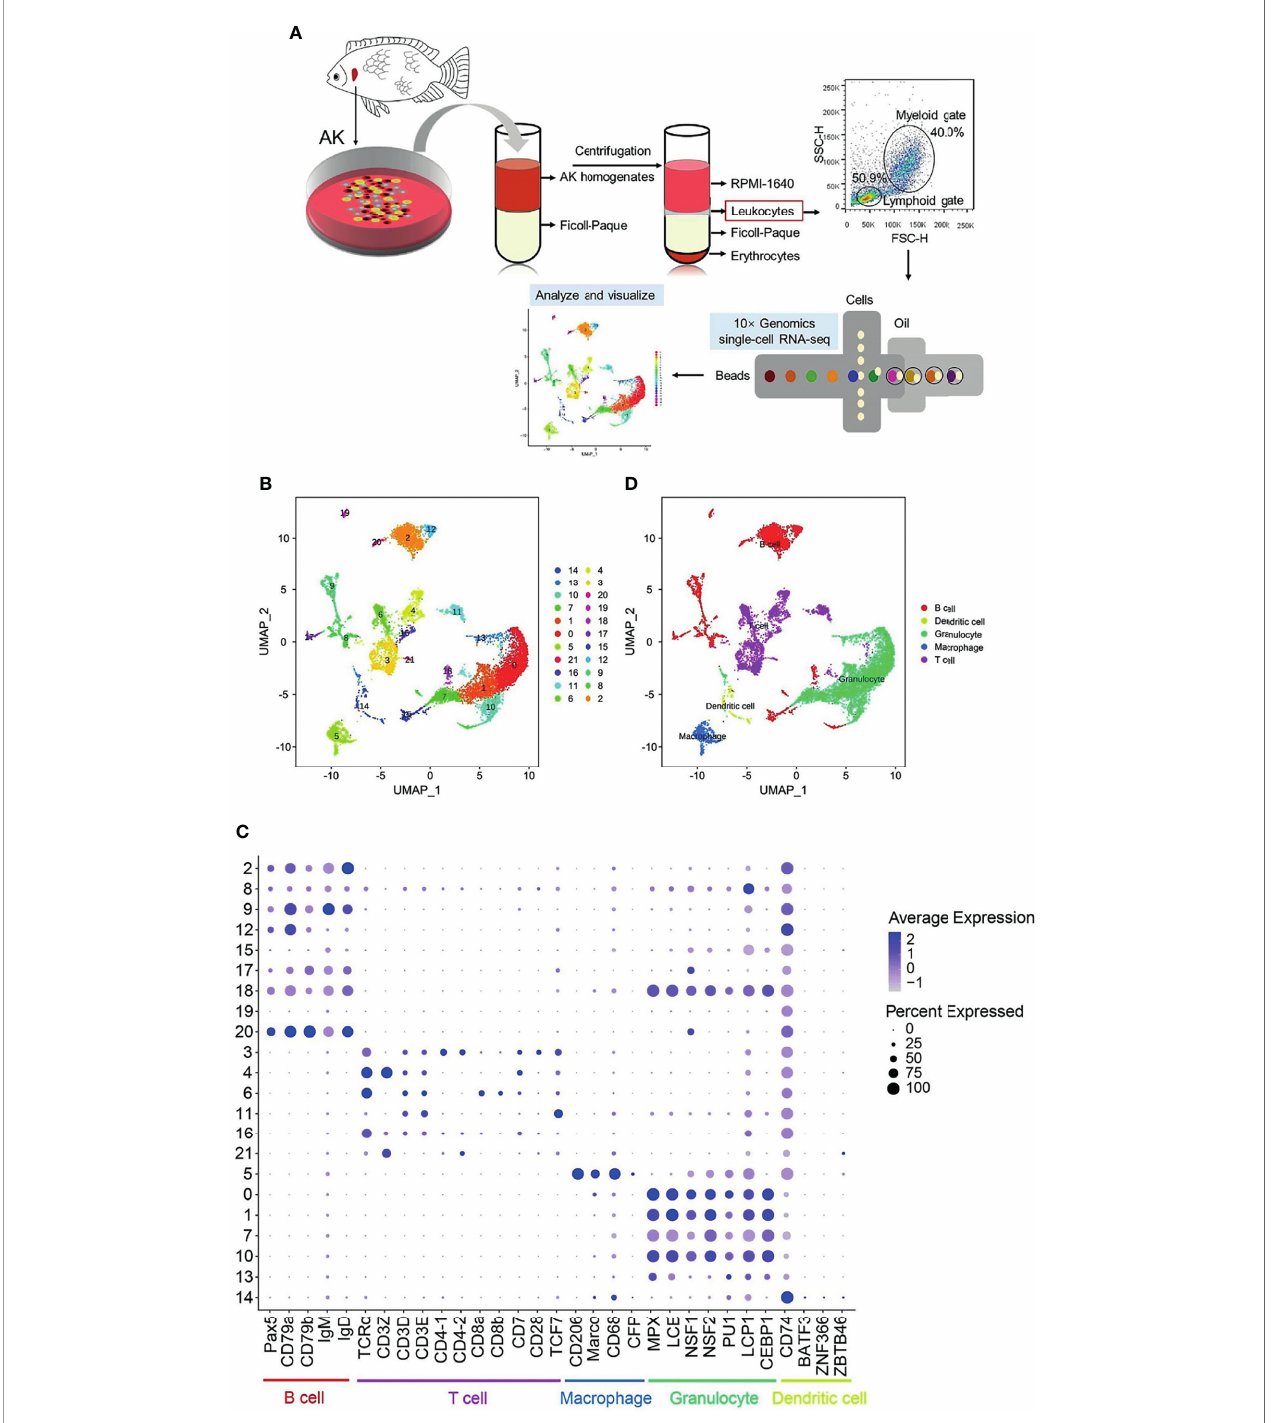
FIGURE 1 | Single-cell RNA sequencing (scRNA-seq) analysis of Nile tilapia anterior kidney (AK) leukocytes. (A) Experimental work fl ow for the scRNA-seq of leukocytes from Nile tilapia AK, including cell separation, fl ow cytometry detection, and 10× Genomics Chromium 3 ′ scRNA-seq and data visualization. (B) A total of 22 cell clusters were identi fi ed and shown with a uniform manifold approximation and projection (UMAP) space. (C) Bubble chart of the putative marker genes for B cells, T cells, macrophages, granulocytes, and dendritic cells (DCs) in the cell clusters. The dot size and color intensity represent the gene expression percentage and the average expression levels of the cells within a cluster, respectively. (D) Identi fi cation of the putative cell types based on the expressions of marker gene in both mammals and fi